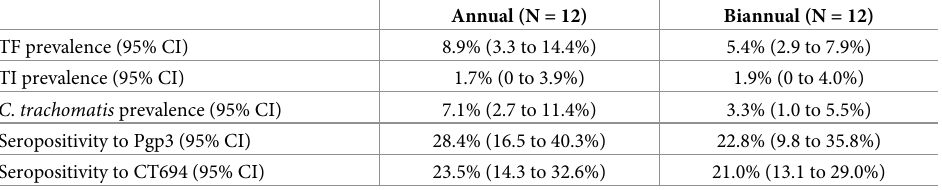
Table 2. Community-level trachoma indicators by study